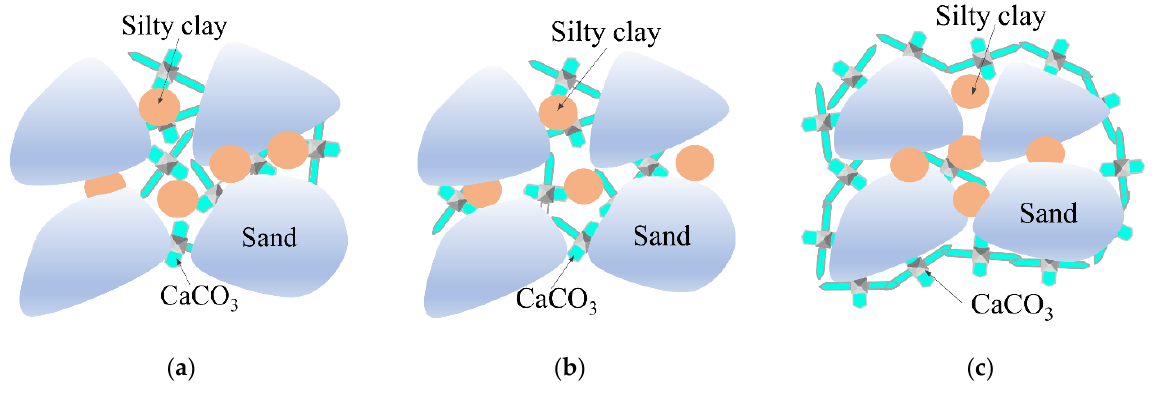
Figure 13. Differences of mineralization modes of different cementation solution concentrations. ( a ) Calcite precipitation. ( b ) Calcite cruciform cementation. ( c ) Calcite wrapped cementation